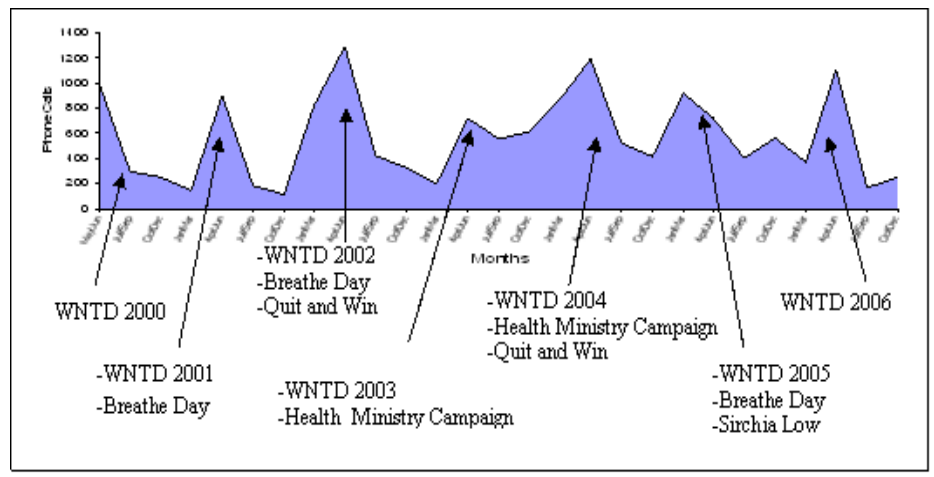
Figure 2. Monthly Trend of Phone Calls connected with main Italian Anti-tobacco Campaigns (May 2000 – December